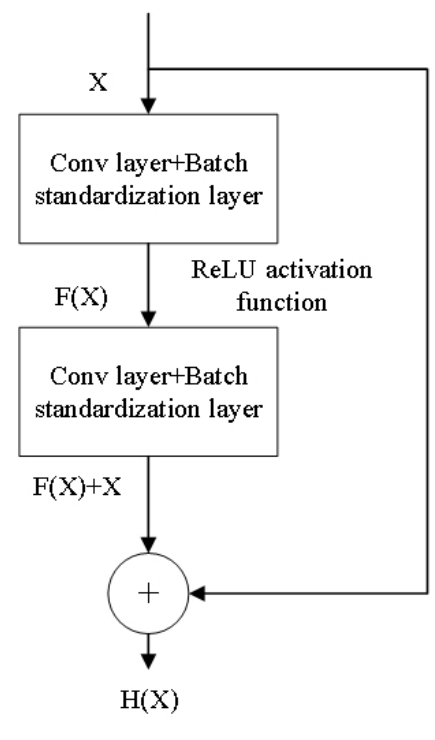
Fig. 1. Structure diagram of residual